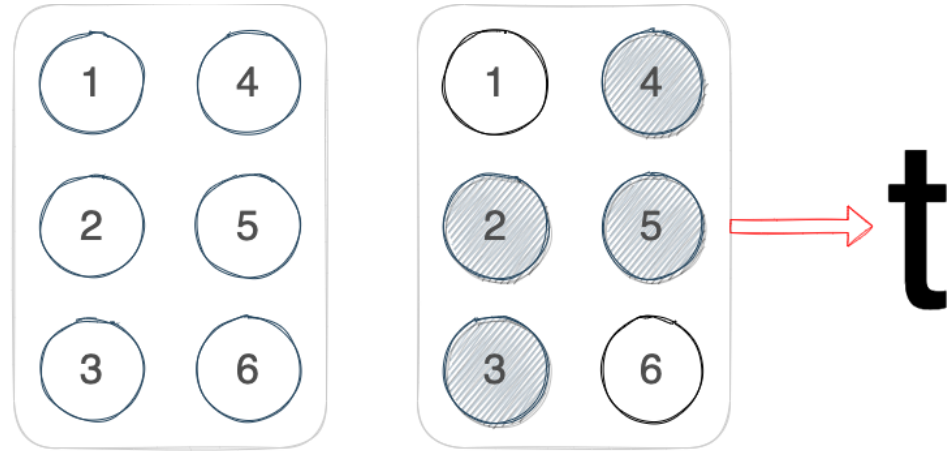
Figure 1. The Braille cell ( left ) and the pattern representing the letter t ( right